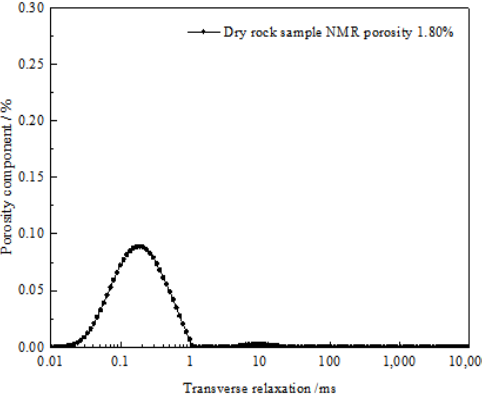
Figure 8. NMR T 2 spectrum of dry rock sample (single peak).